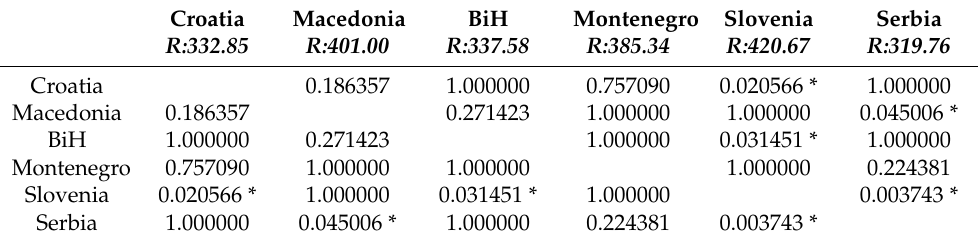
Table 1. Comparison of children’s dental anxiety (CDAS) by country; multiple comparisons p values (2-tailed); children dental anxiety (DA); independent (grouping) variable: country; Kruskal–Wallis test: H (5, n = 731) = 23.40126 p = 0.0003.